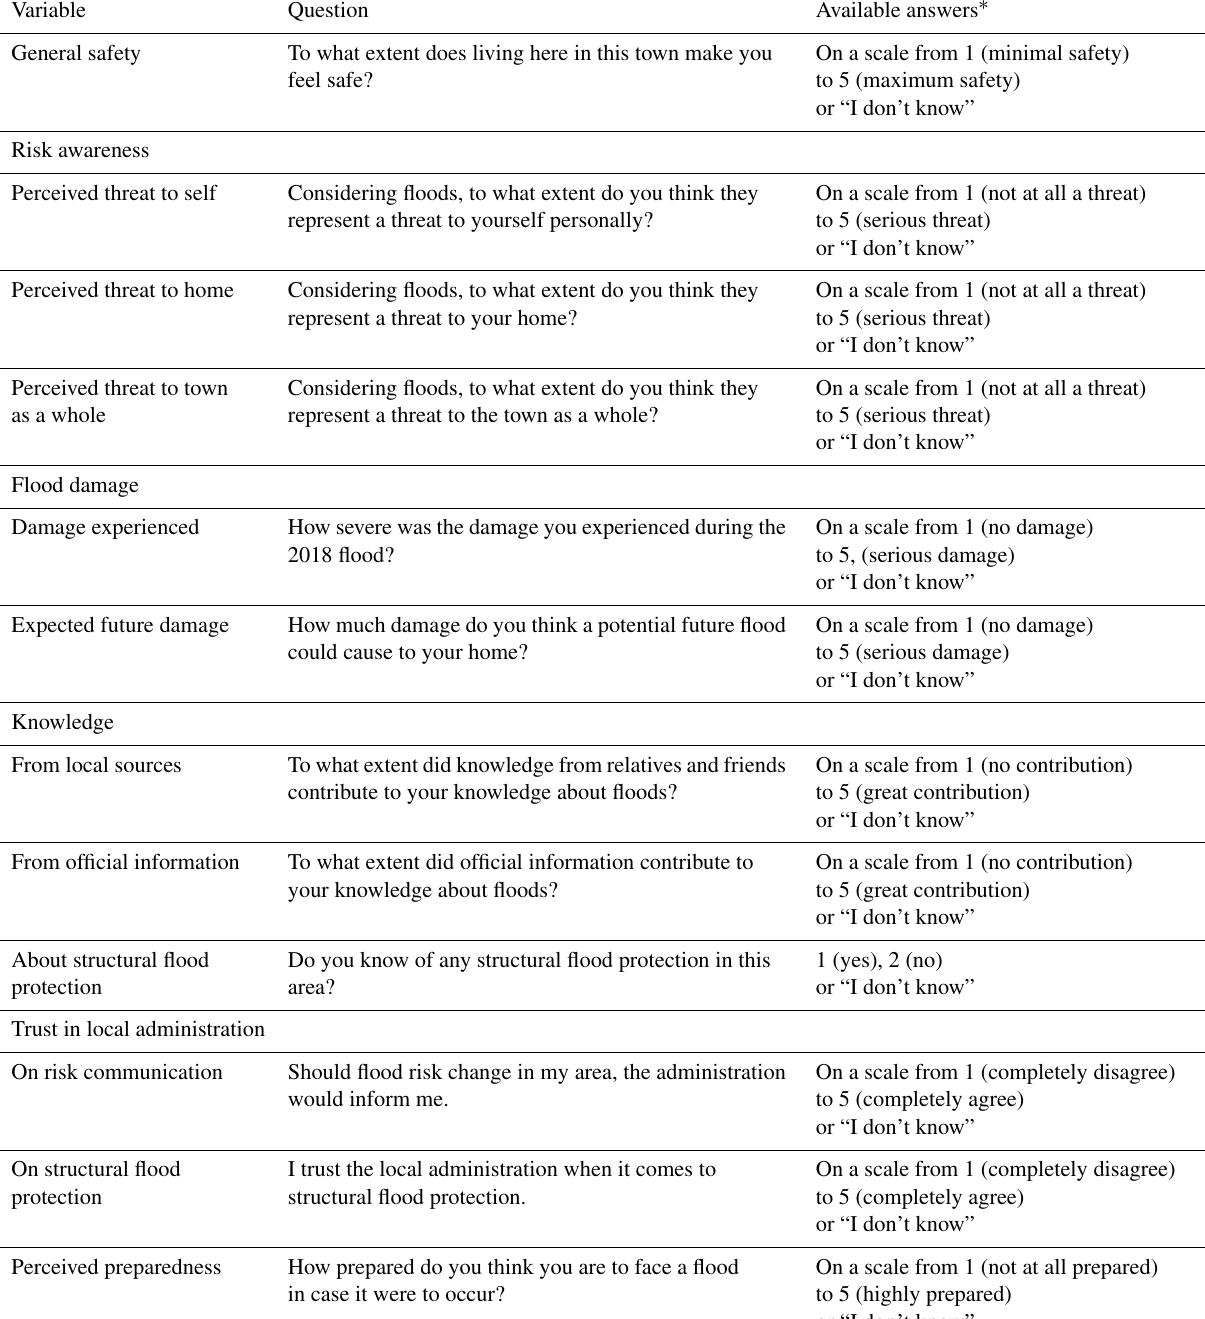
Table 2. Main variables employed in the analysis.